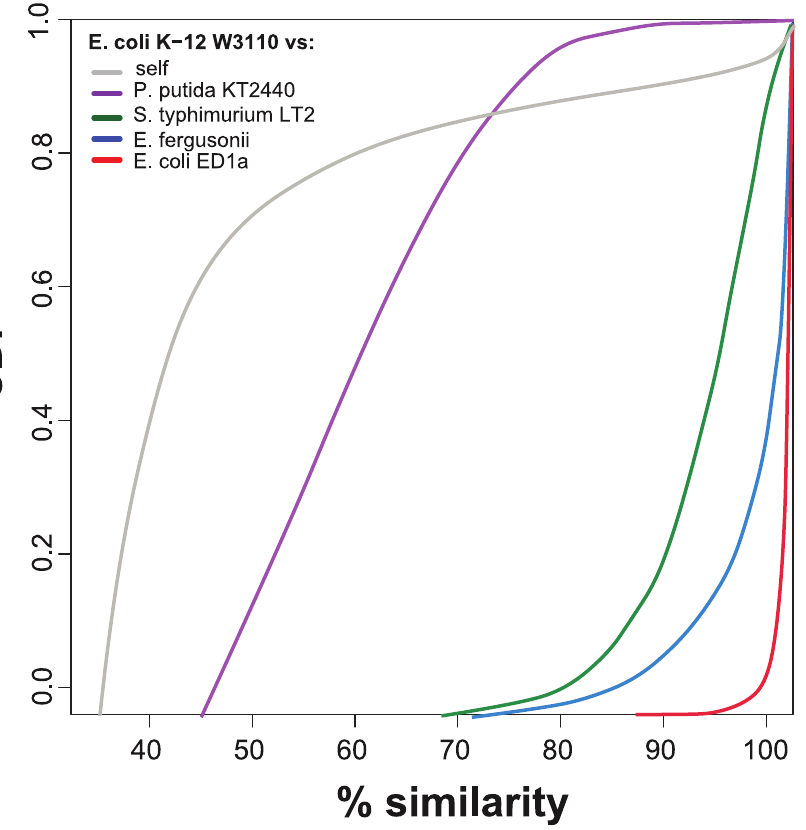
Figure 7. Cumulative distribution function plot of protein similarity. Colored lines correspond to CDF plots of the similarity between orthologous proteins of the core genome for the comparison of E. coli K12 W3110 with genomes of increasing phylogenetic distances. The gray line corresponds to the similarity between homologous genes in the E. coli K12 W3110 genome.